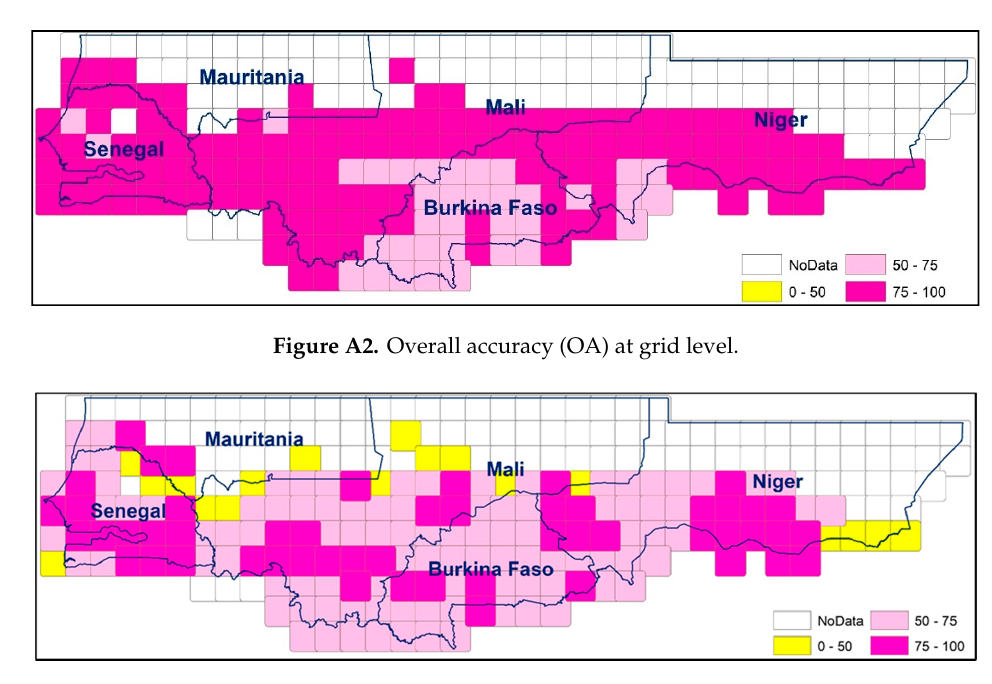
Figure A1. Occurrences of the number of tree (nTree) corresponding to minimum out-of-bag errors ( A ) and the obtained number of variables available for splitting at each tree node, mTry ( B ).